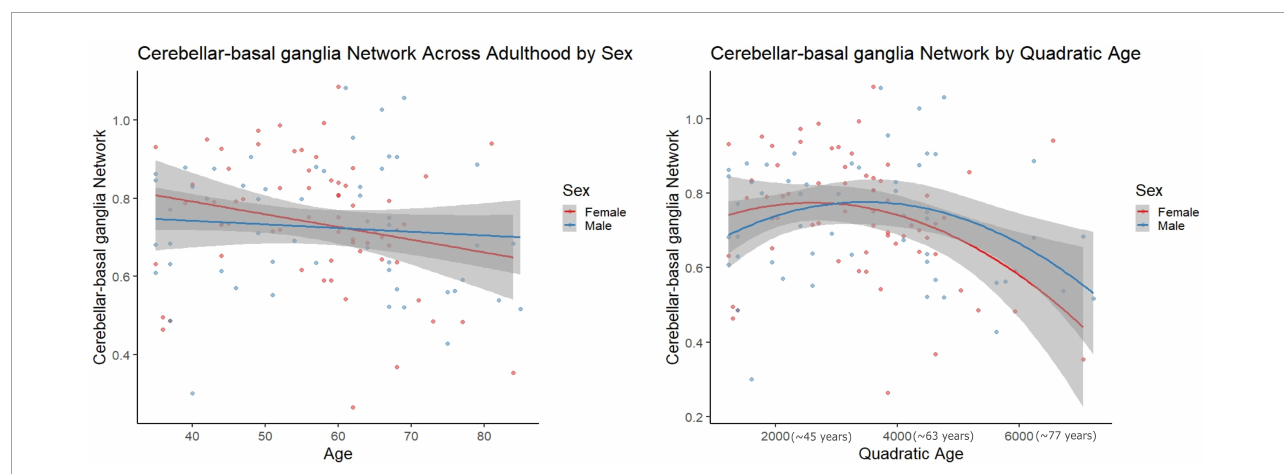
FIGURE3 Scatter plots demonstrate the linear (left) and quadratic (right) relationship between Cerebellar-basal ganglia network connectivity and age. Parentheses next to quadratic values (right) indicate the approximate square root of the quadratic value for interpretative purposes. The gray superimposed on each colored line depicts the 95% confidence interval in each